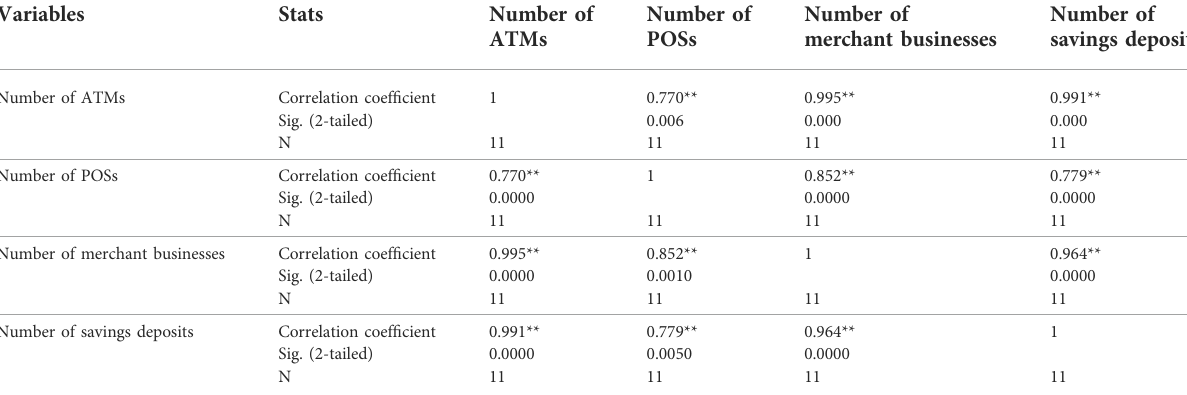
TABLE 14 Spearman ’ s correlation analysis by number of ATM-POS, number of merchant businesses, and number of savings deposits.